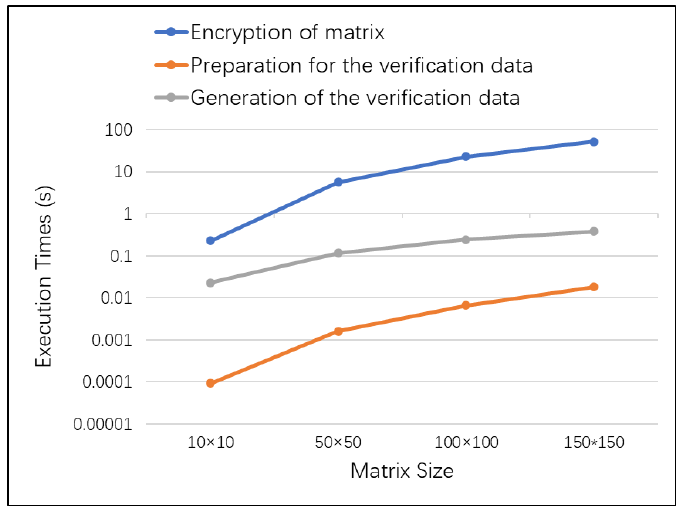
Figure 3. The time cost for the function